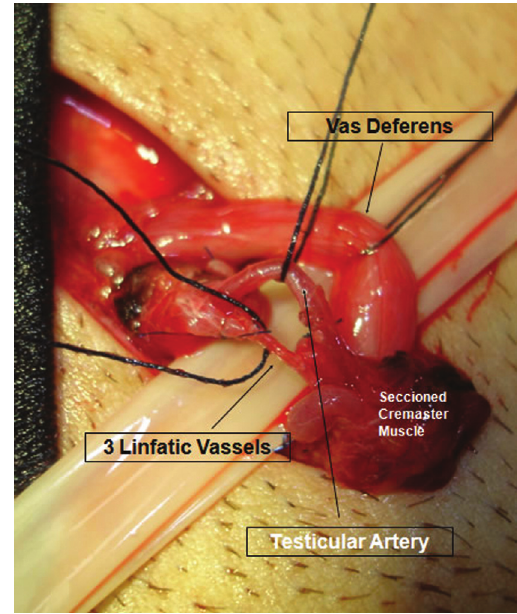
Figure 4 - View after